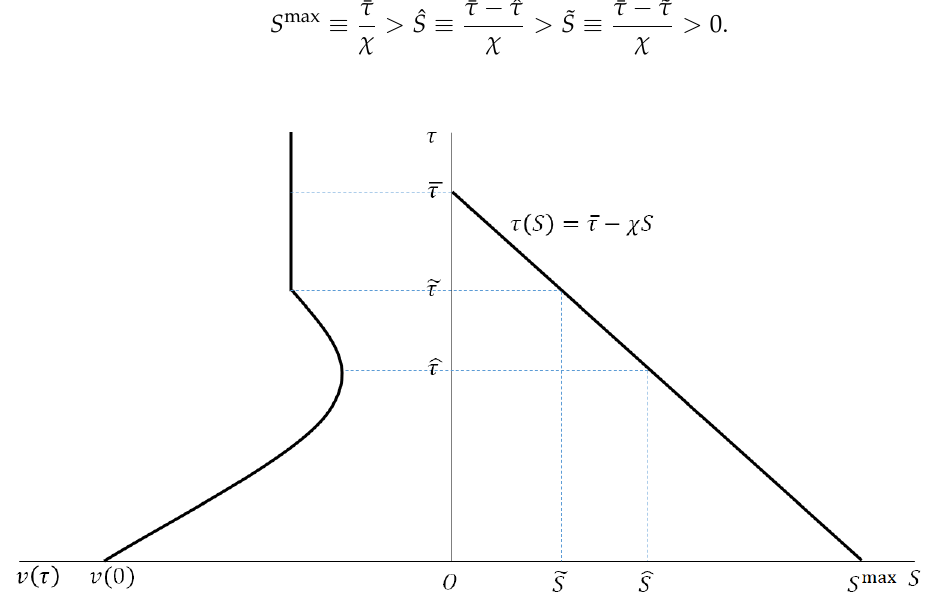
Figure 3. Threshold levels of τ and S